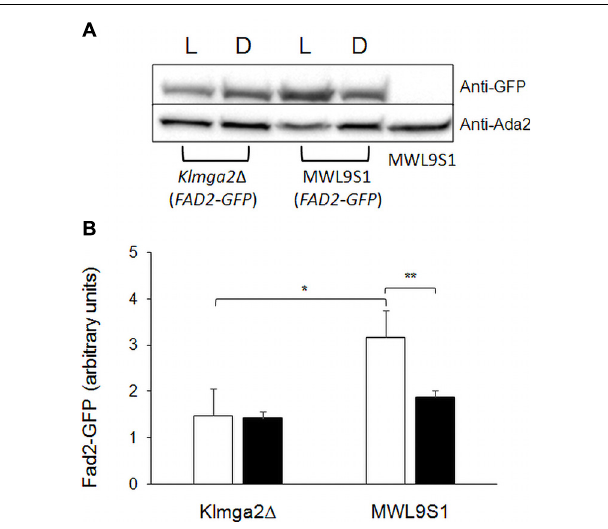
FIGURE 10 | Fad2 production in Klmga2 (cid:49) mutant strain and wild type. (A) Shows a Western blot against Fad2-GFP protein, using extracts of strains LD2G and Klmga2 (cid:49) / Fad2-GFP grown overnight in light (L) and dark (D) conditions. Ada2 protein was used as loading control. (B) Reports a Fad2-GFP signal quantification of repeated Western blot experiments. White blocks represent Fad2-GFP in light and black blocks in darkness, respectively. SD are indicated. Statistical significance: * p < 0.05, ** p <